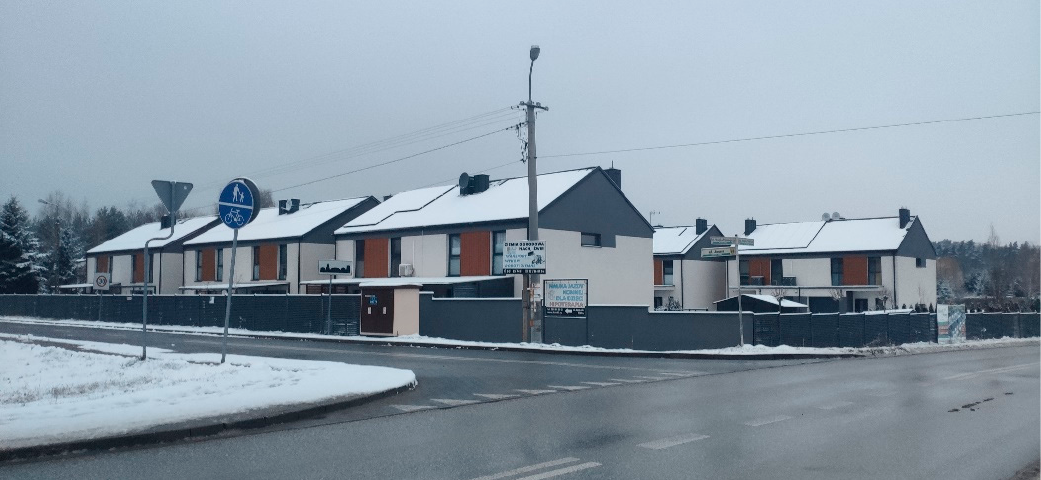
Figure 5. An example of a typical new micro housing estate in the suburbs of